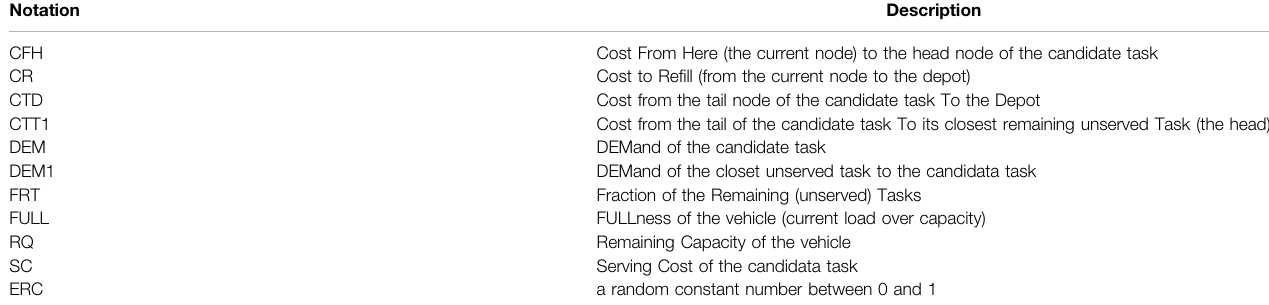
TABLE 2 | The terminal set.